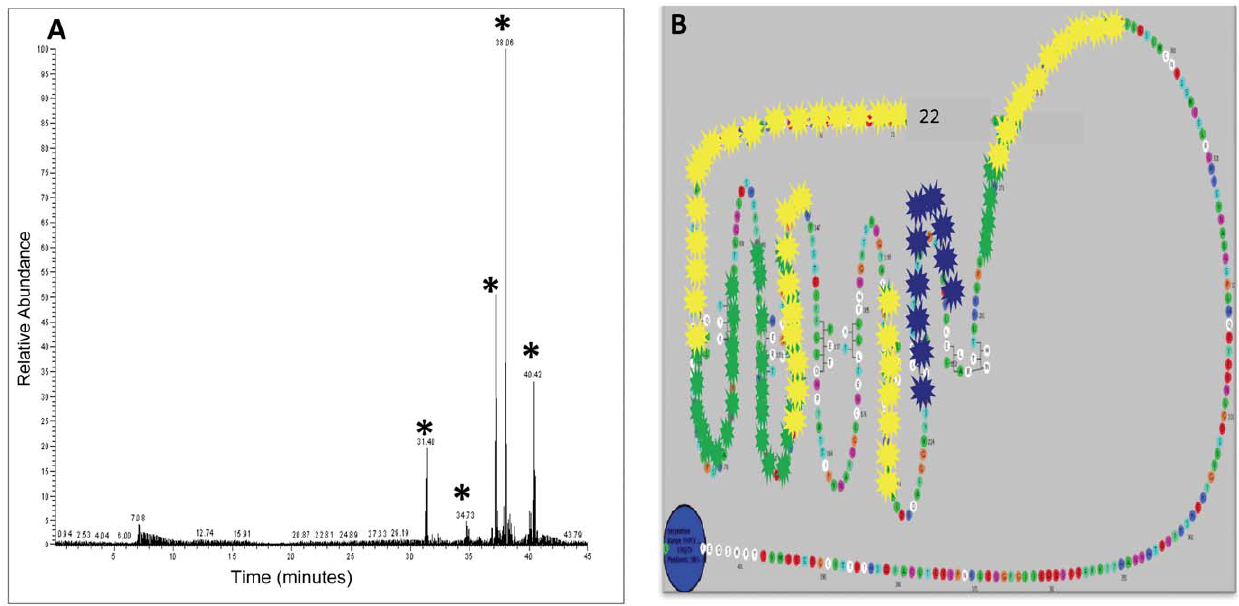
Figure 4. Mass spectrometry and mapping of protected epitopes of MS-1 and M22. Panel A - The antibody protected peptides were eluted and fed into the mass spectrometer which scanned the incoming peptides based on user defined criteria in the database and was able to select TSHR specific tryptic peptides. By this method we obtained five major peaks for peptides protected by MS-1(marked by an asterisk). The captured peptides were dissociated in an ion spray and the masses of the component amino acids measured and identified. Additional profiles are provided as Supplementary Material. Panel B - The common regions, indicated by the yellow stars, and regions that were unique to each of the stimulating antibodies, indicated by the blue (M22) and green (MS-1) stars, illustrate the relative similarity and difference between the protected regions of these two antibodies. The exact contact residues for M22 (red circles) obtained from the crystal structure [20] when overlaid on this model identified , 60% of the reported residues. The regions on the leucine rich repeats contacted by MS-1 corresponded to LRD 1, 4, 7, 8 and 9. In addition two regions outside the LRD were protected, one region was on the amino terminus starting and the second large region in the N- terminus of the hinge region. Similarly the regions contacted by M22 corresponded to LRD 1, 2, 3, 4 and 7. As seen with MS-1, the amino terminus and hinge region epitopes were also protected. These epitope protection studies were repeated three times (n=3) for each antibody.